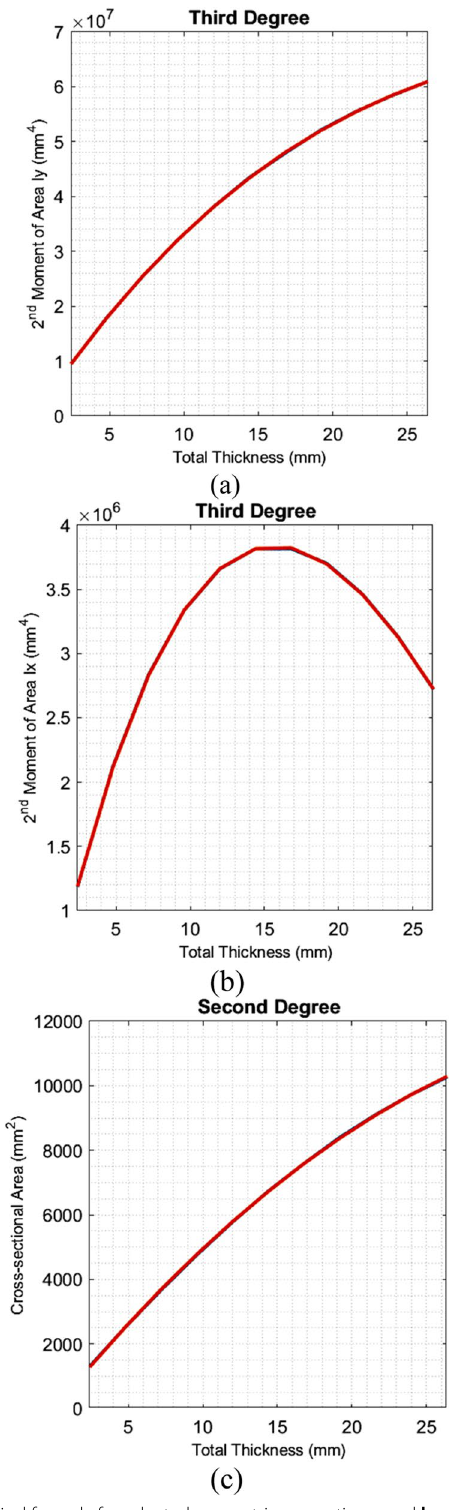
Fig. 2 Curve fitting empirical formula for selected geometric properties. a and b are the second moment of area at y -axis and x- axis respectively; the formula is third-degree order; c is the cross-sectional, area and the formula is second-degree